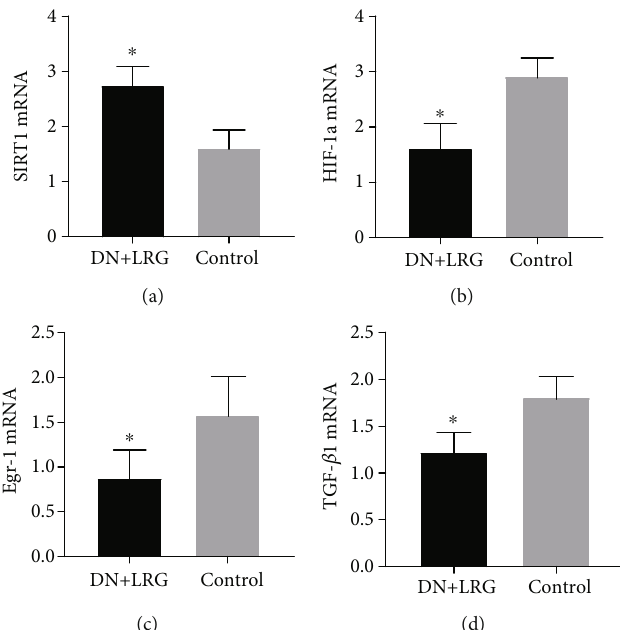
Figure 6: Expression levels of SIRT1, HIF-1a, Egr-1, and TGF- β 1 mRNAs in the kidney. Control: diabetic nephropathy group; DN+LRG: diabetic nephropathy+liraglutide group; Egr-1: early growth response-1; HIF-1a: hypoxia-inducible factor-1 alpha; TGF- β 1: transforming growth factor- β 1. ∗ P < 0 : 05 vs. the control.